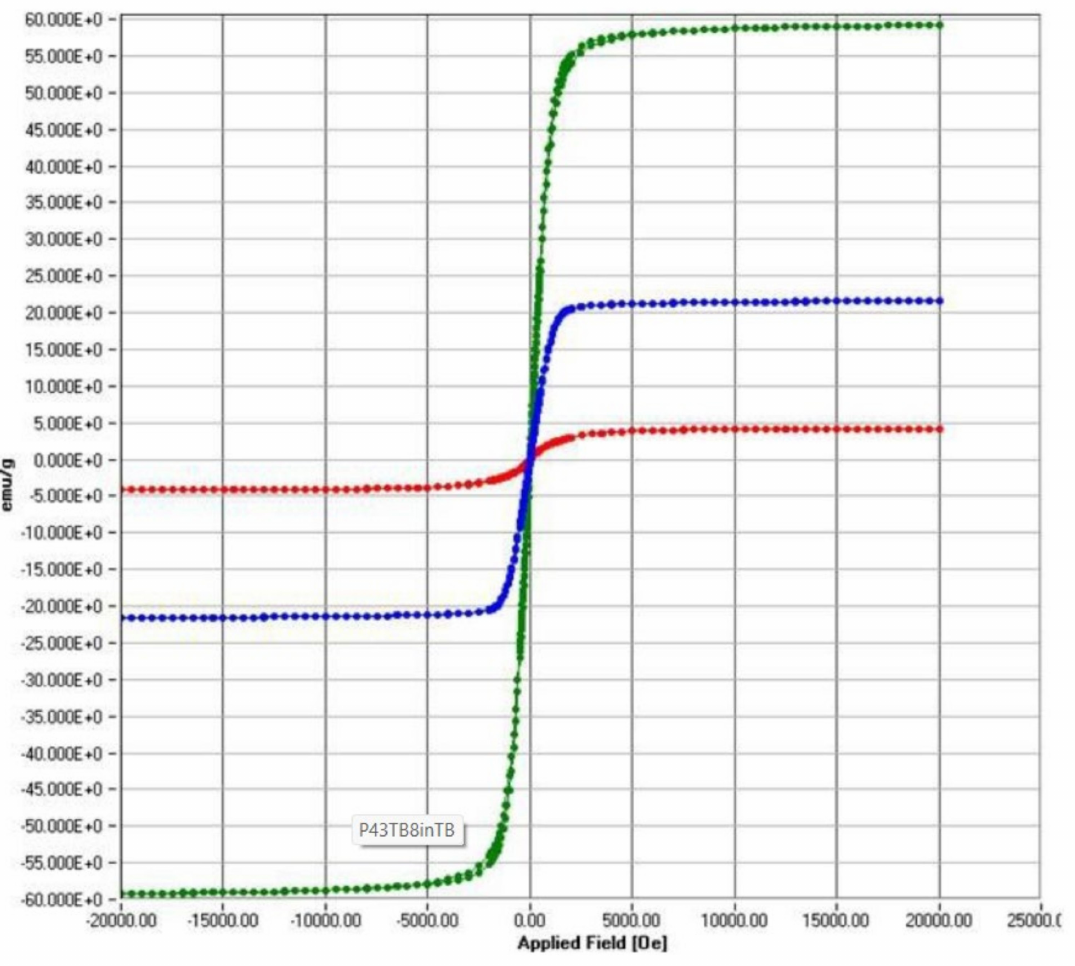
Figure 4. Room temperature hysteresis loops for the S sample (red); U sample (blue); M sam- ple